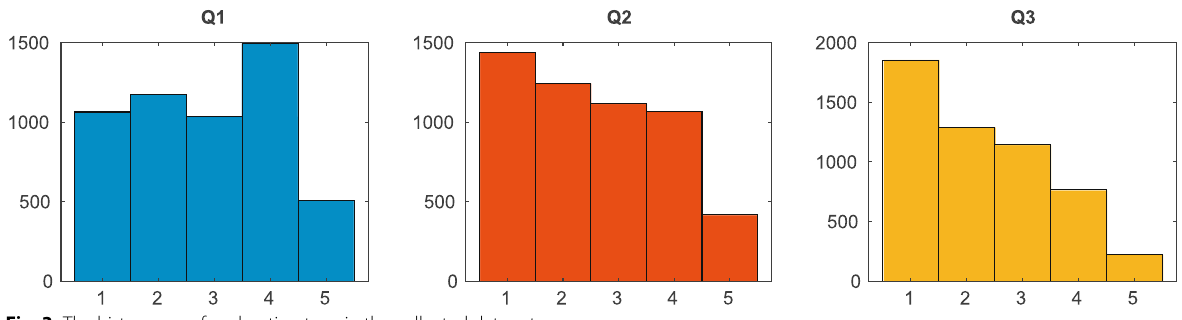
Fig. 3 The histograms of each rating type in the collected data